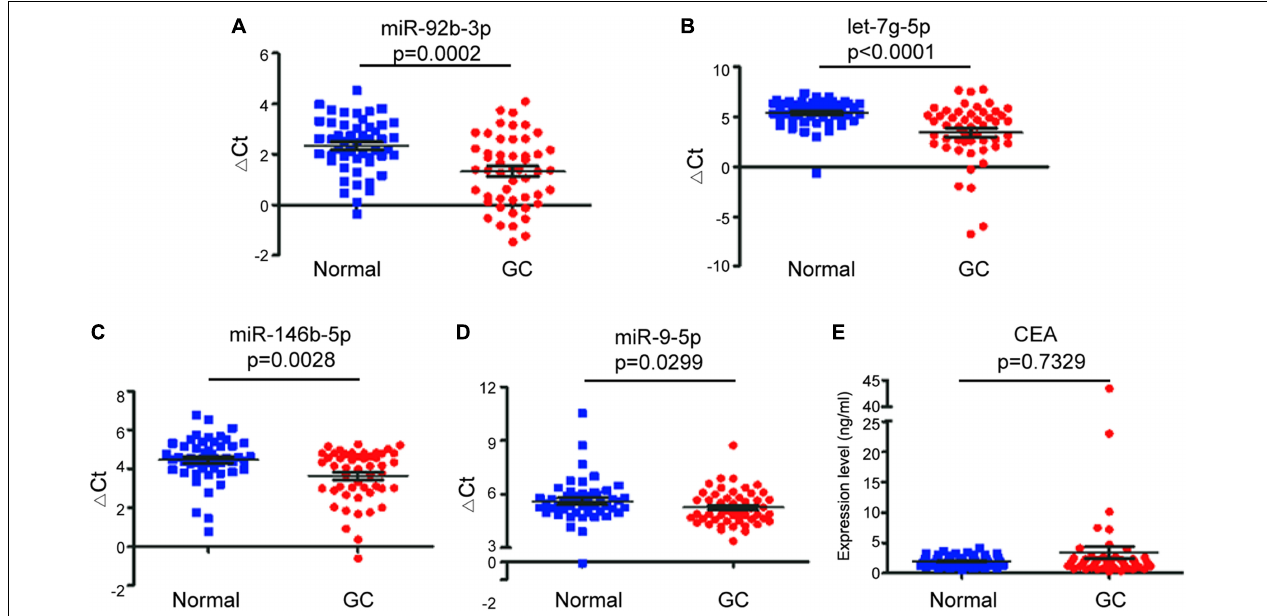
FIGURE 2 | Comparison of expression of exosomal miRNAs in early-stage GC patients (GC) and healthy individuals (Normal). The scatter plots of the mean ± SD of (cid:49) Ct values of miR-92b-3p (A) , let-7g-5p (B) , miR-146b-5p (C) , and miR-9-5p (D) , and the mean ± SD of expression levels of serum CEA (E) between early-stage GC patients and healthy individuals.